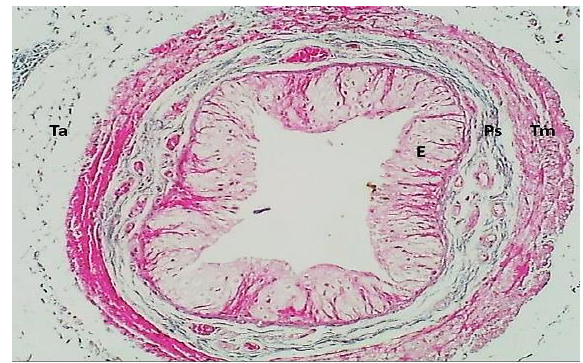
Figure, 10: Histological section of ureter shows: epithelium (E), propria submucosa (Ps), tunica muscularis (Tm) and tunica adventitia (Ta). H&E stain.